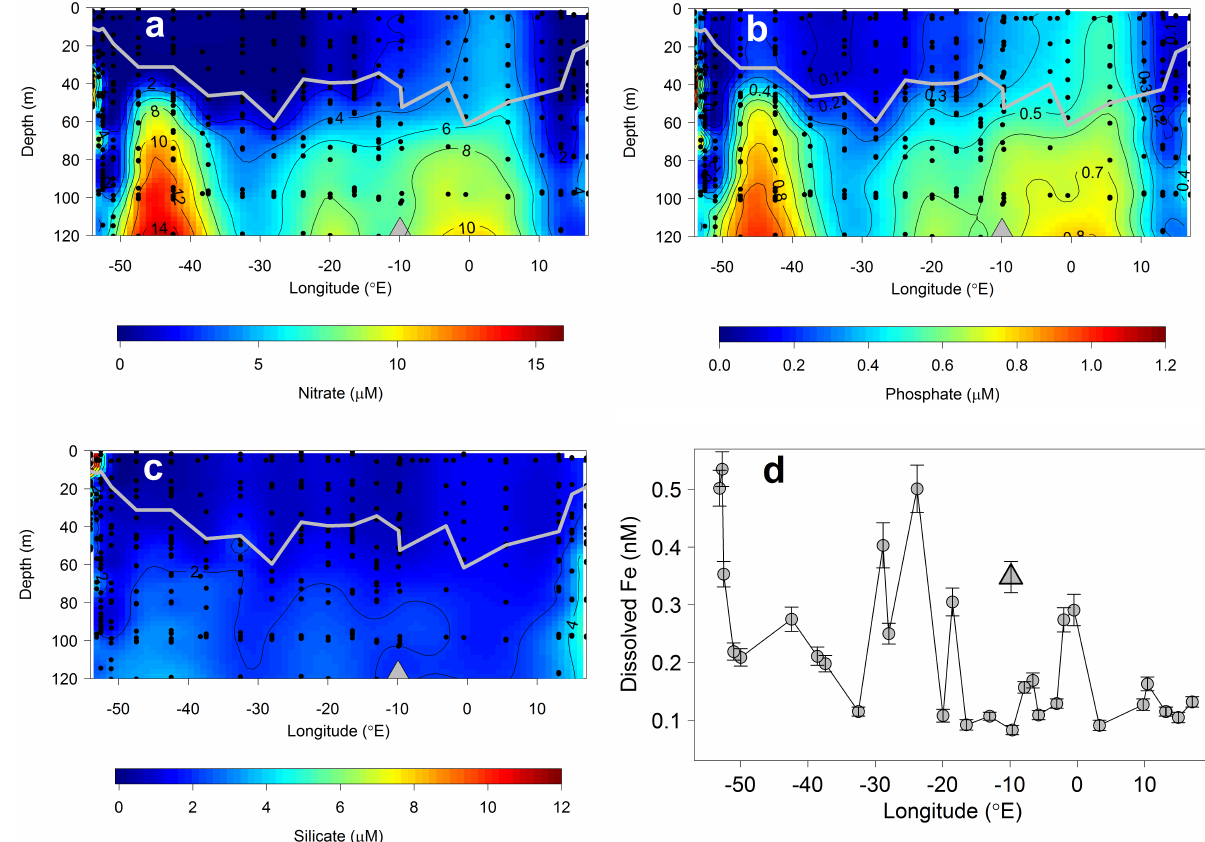
Fig. 2. Cross-basin section of macronutrient concentrations: (a) nitrate; (b) phosphate; (c) silicate. Grey lines indicate the MLD and grey triangles indicate the location of Gough Island. (d) Surface ( ∼ 2–5m) dissolved Fe concentrations. Error bars represent the standard deviation calculated as the accuracy of the spike ratio ( ∼ 4%) and the counting accuracy of the ICP-MS. The point labelled with a triangle represents the DFe concentration for Station 9 (next to Gough